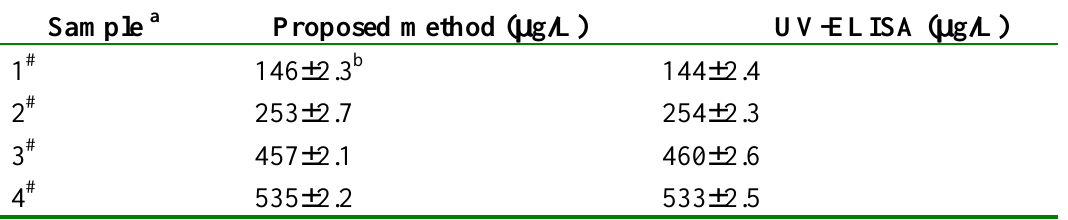
Table 2. BrAb determination with the proposed fluoroimmunosensing system in rabbit serum